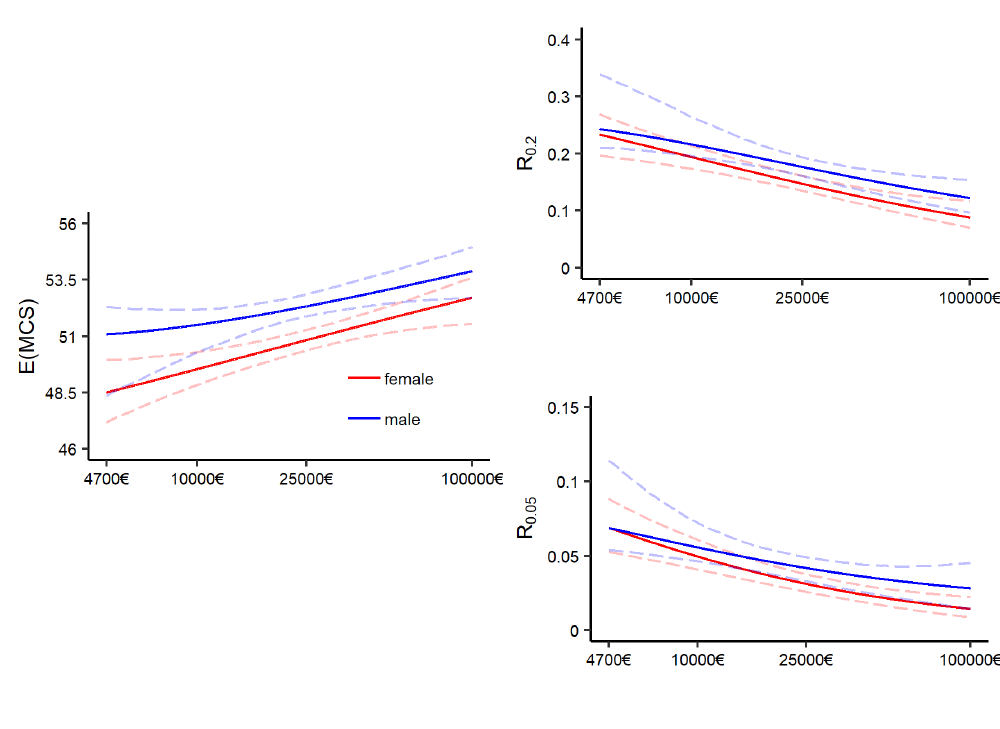
Figure A4. Effect of income on distribution measures for the GB2 model: GB2 ( µ = (cid:88) , σ = (cid:88) , ν = (cid:88) , τ = (cid:88) ). Left : Effect of income on the expectation; right : Effect of income on risk of falling below the lowest quintile and lowest